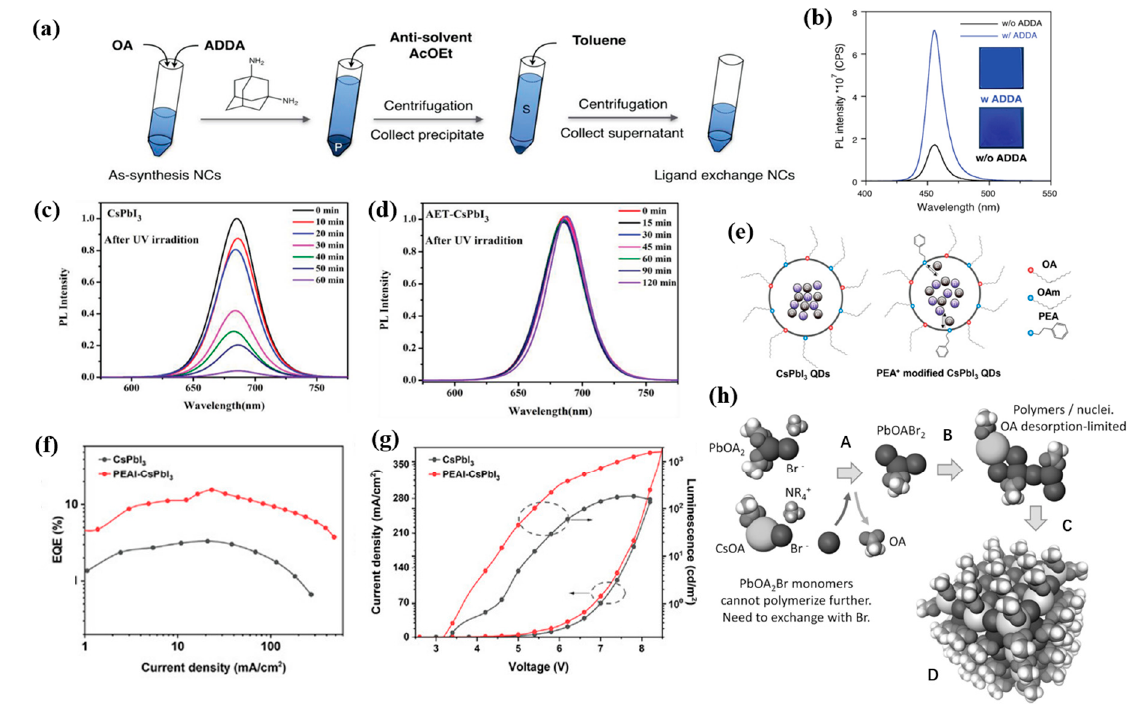
Figure 4. ( a ) Scheme of the ligand exchange and purification process; ( b ) PL spectra of CsPb(Cl/Br) 3 NC films. Reproduced with permission from Ref. [40]. Copyright 2020, Wiley. Evolution of the PL spectra of ( c ) CsPbI 3 QDs and ( d ) AET–CsPbI 3 QDs after UV illumination for different times. Reproduced with permission from Ref. [85]. Copyright 2019, Wiley. ( e ) Schematic diagram of the effects of PEA + ligands on carrier behavior in the QDs; ( f ) EQE– J curves of the LEDs based on the pristine CsPbI 3 QDs and PEAI − CsPbI 3 QDs; ( g ) J – V – L curves of the LEDs based on the pristine CsPbI 3 QDs and PEAI–CsPbI 3 QDs. Reproduced with permission from Ref. [86]. Copyright 2022, Wiley. ( h ) Density functional theory molecular dynamics simulation of CsPbBr 3 nucleation and growth steps. Reproduced with permission from Ref. [21]. Copyright 2016, Wiley.